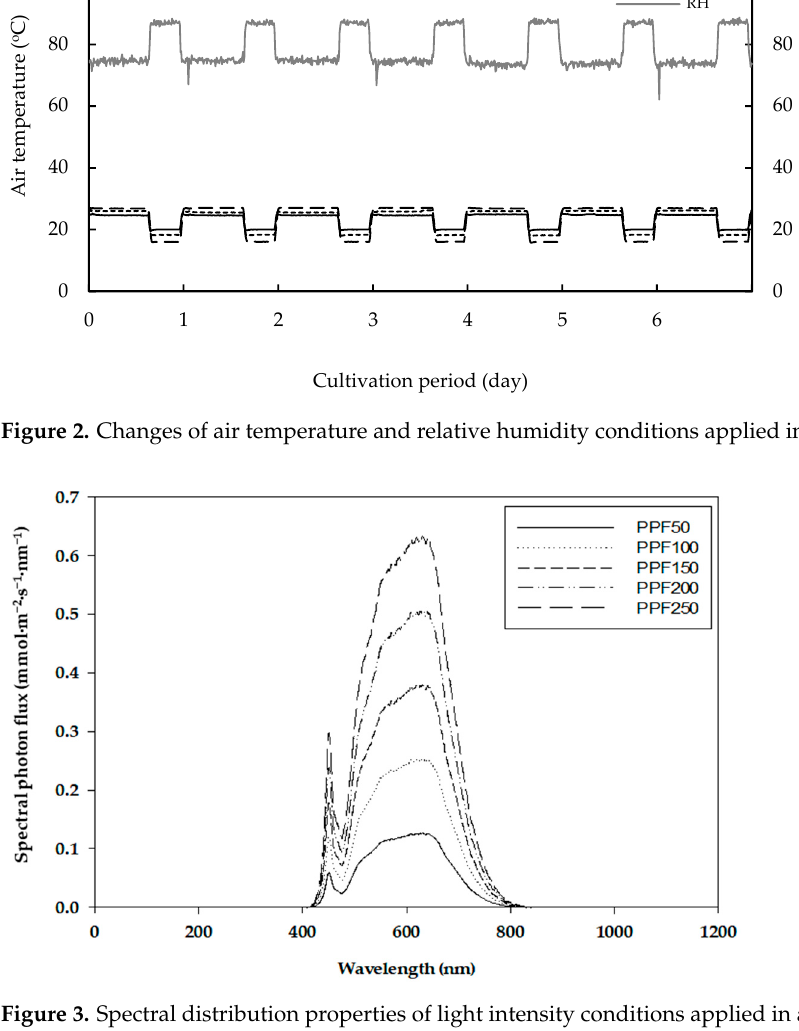
Figure 3. Spectral distribution properties of light intensity conditions applied in a PFAL.